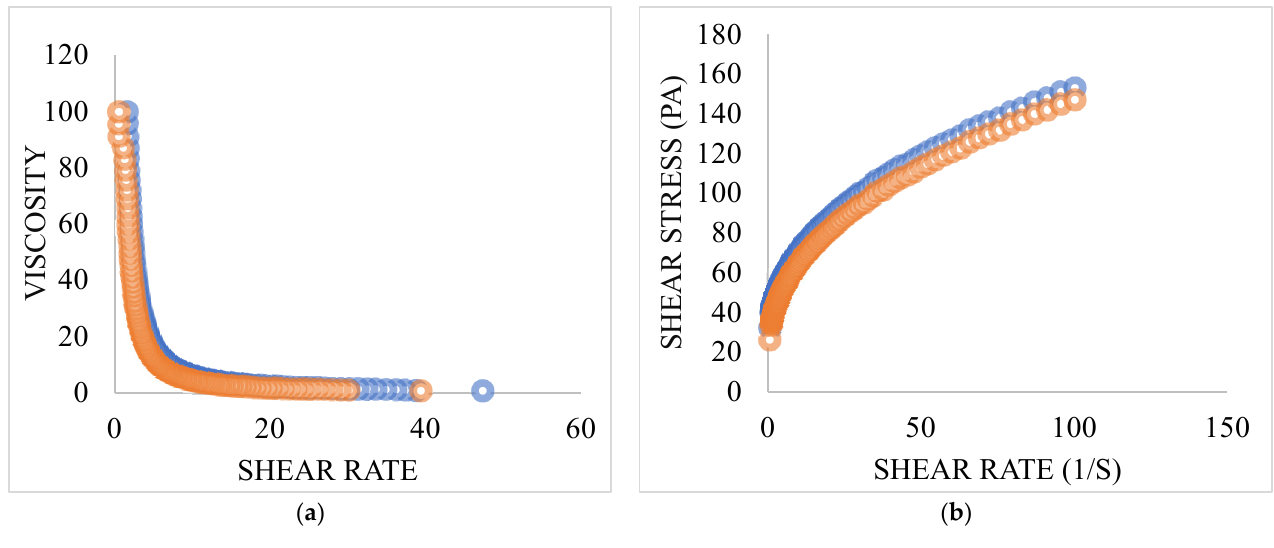
Figure 6. Gel rheological measurements with the help of a rheometer at 25 °C with variations in the ( a ) viscosity; ( b ) shear stress with respect to change in the shear rate. (Orange colour: Ethosmal gel, Blue colour: Conventional gel).